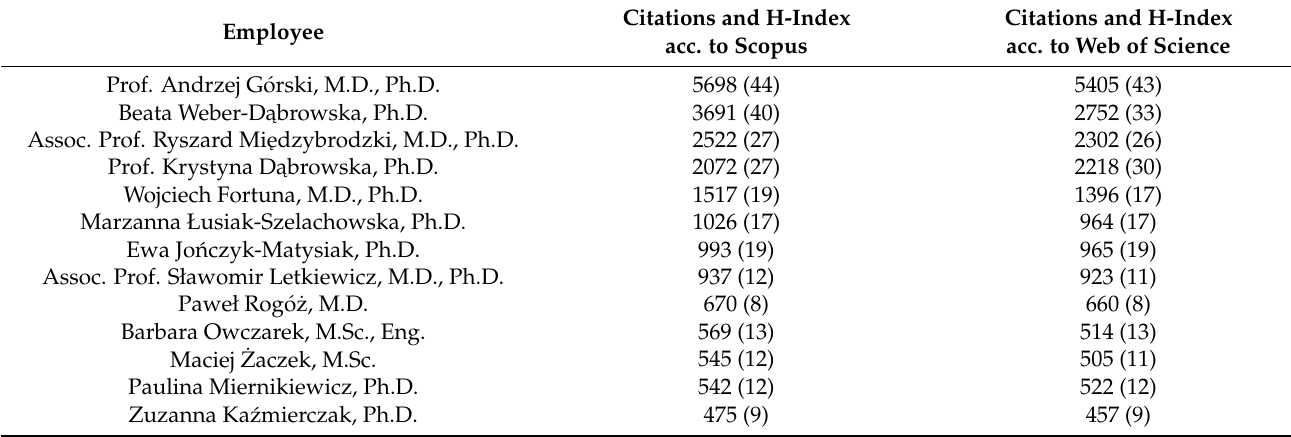
Table 6. Scientific metrics of the current employees of phage-related units of the Hirszfeld Institute with the greatest number of citations * according to the Scopus and Web of Science databases (as of 13 April